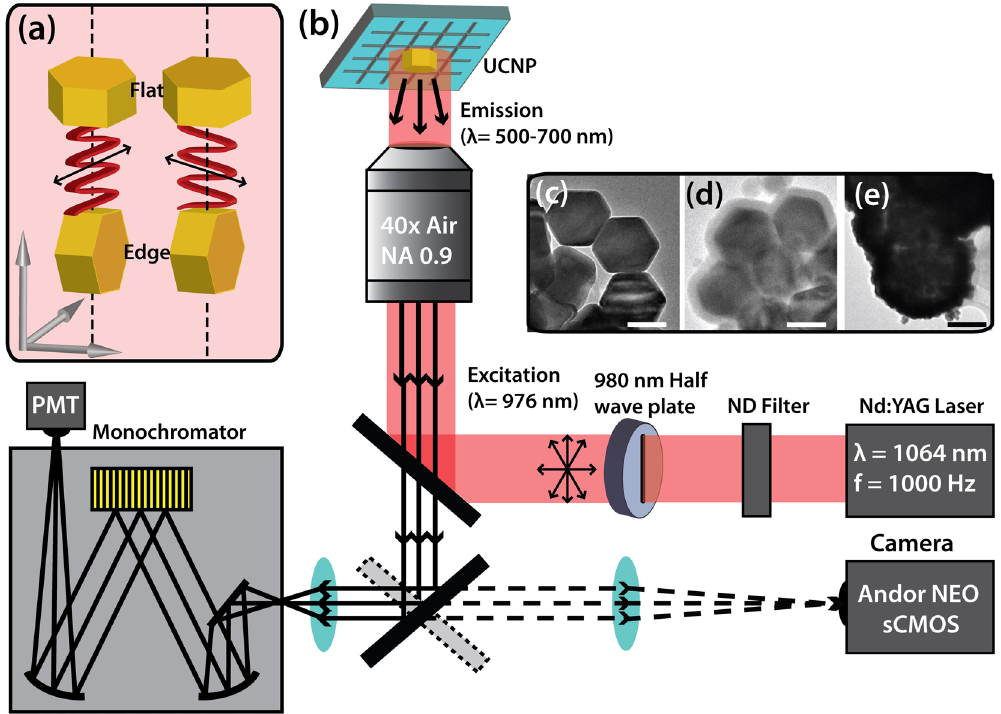
Figure 1. ( a ) Incoming polarization with respect to the orientation of either flat or on-edge particles. The optical experimental set up is displayed in ( b ). The modification process from unmodified UCNP ( c ) through silanization ( d ) to gold shell growth ( e ) is also